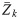
Example of S(t) and β(t) reconstruction with an overestimate of S0 corrected by peak-to-peak iteration (PTPI).[Panel A] Truncation step of PTPI (Box 5). Plotted is a reconstruction of true incidence Z(t) from a simulated reported incidence time series, before [Zk, black] and after [Z¯k, yellow] smoothing with a 13-point central moving average. Vertical lines indicate peaks in Z¯k. The times of the first peak in Z¯k and the last peak occurring at the same phase of the cycle (in this case, the last peak) are denoted by ta and tb. [Panel B] Iteration step of PTPI (Box 6), where the initial estimates of both S0 = S(0) and S(ta) were taken to be 4 times the true (data-generating) value of S0. Plotted in grey are successive reconstructions of S(t) between times ta and tb, generated by updating the estimate of S(ta) with the estimate of S(tb) obtained in the previous iteration. Dashed continuations to the left of ta display estimation of S0 backwards in time from estimates of S(ta). Plotted in black is the result of reconstructing S(t) starting from the final estimate of S0, which was obtained after 25 iterations and had a relative error of roughly 1.4% (compared to 300% in the initial estimate). [Panel C] The sequence of reconstructions of β(t) corresponding to the estimates of S0 shown in Panel B. [Details] Twenty years of weekly reported incidence (Δt = 1 week, n = 1042) were simulated with environmental noise in transmission (ϵ = 0.5), demographic stochasticity, and random under-reporting of cases (prep = 0.25), using reference values (Table 1) for the remaining parameters. Z(t), S(t) and β(t) were reconstructed from reported incidence using the SI method without input error (apart from mis-specification of S0).